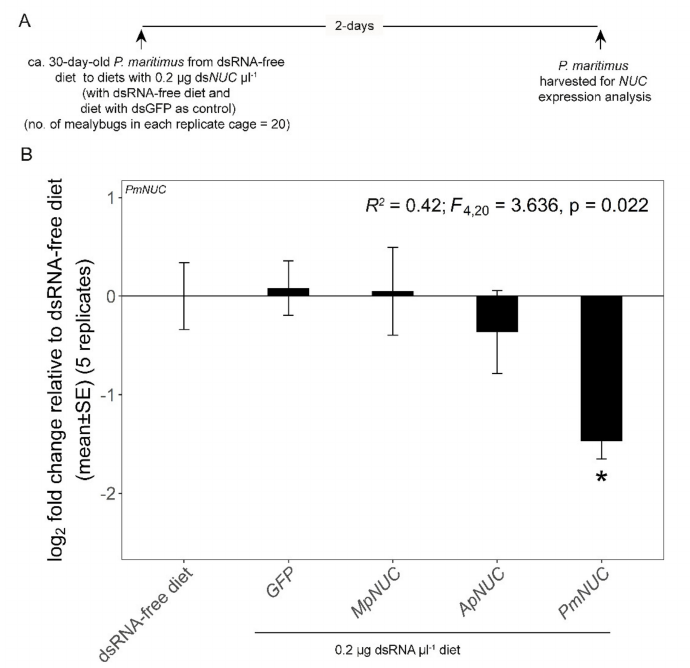
Figure 4. Activity of aphid ds NUC against NUC gene expression in P. maritimus . ( A ) Experimental design. ( B ) P. maritimus NUC gene expression. The pooled data for two iterations of the experiment are shown (with three and two replicate cages per treatment in the first and second iterations, respectively). Linear model statistics were employed using dsRNA-free diet as the intercept to identify significant effects of various dietary dsRNAs on NUC expression. Asterisks identify treatments that are significantly different from dsGFP-free diet at α = 0.05. ApNUC , A. pisum NUC ; MpNUC , M. persicae NUC ; PmNUC , P . maritimus NUC